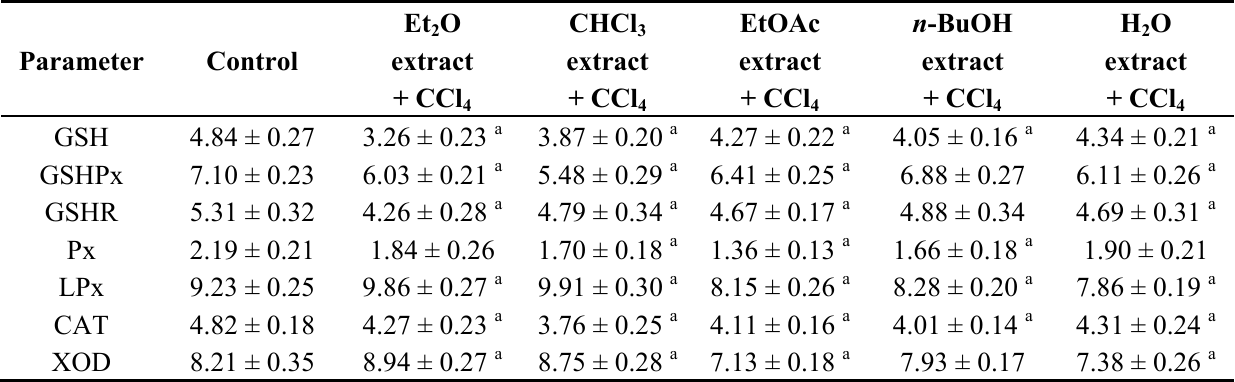
Table 6. Effect of extracts of T. pratense leaves and CCl blood